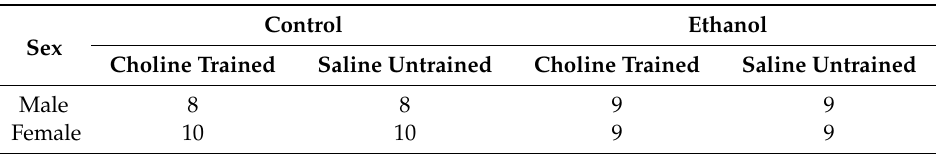
Table 1. Number of rats in each experimental